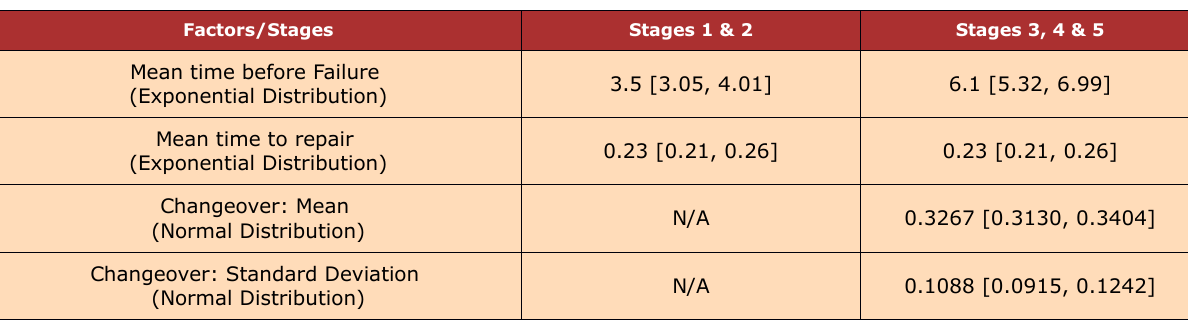
Table 17. Case-2 boundary conditions used in creating LHS samples